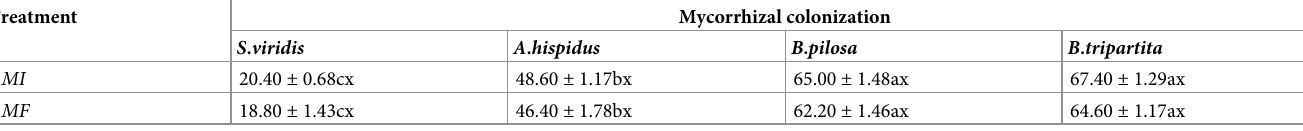
Table 1. The mycorrhizal colonization rates of Setaria viridis , Arthraxon hispidus , Bidens pilosa , and Bidens tripartite . Treatment